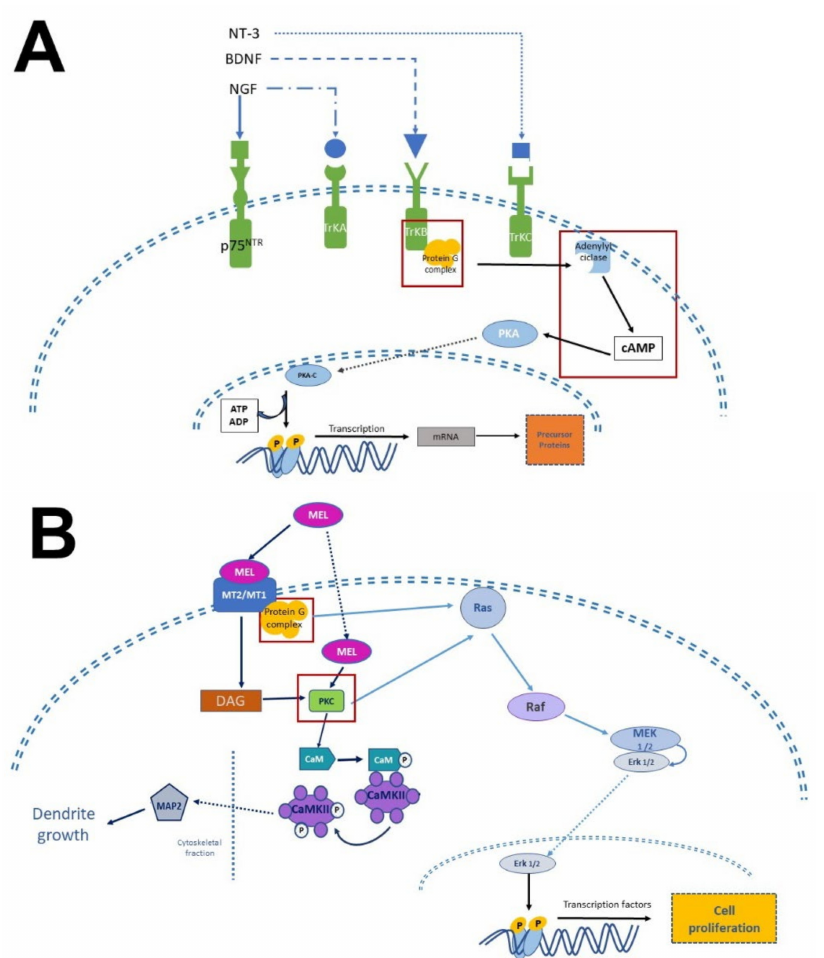
Figure 4. Simplified scheme of neurotrophic factors and melatonin signaling pathways. Panel ( A ) shows the interaction of neurotrophins (NT-3, BDNF, NGF) with their receptors (p75NTR, TrkA, TrkB, TrkC), the activation of G proteins, which in turn activate protein kinase A (PKA) and protein kinase C (PKC) to generate transcription factors and precursor proteins that promote neuronal survival. Panel ( B ) display melatonin (MEL) signaling pathways that promote cell proliferation through binding to melatonin receptors (MT 1 , MT 2 ), which activate the protein G complex and fibrosarcoma kinases (Raf), mitogen-activated protein kinase (MEK) and extracellular signal-regulated kinase (Erk). MEL can also cross plasmatic membranes and bind to calmodulin (CaM); the complex CaM/MEL binds to the enzyme calmodulin kinase II and enhance its activity to stimulate dendritic development and growth. Red squares in both panels indicate the common features in these